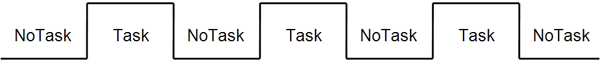
Boxcar diagram procedures. This figure shows the stimuli protocol used in the study ("NoTask" indicates not showed words and "Task" represents showed words).